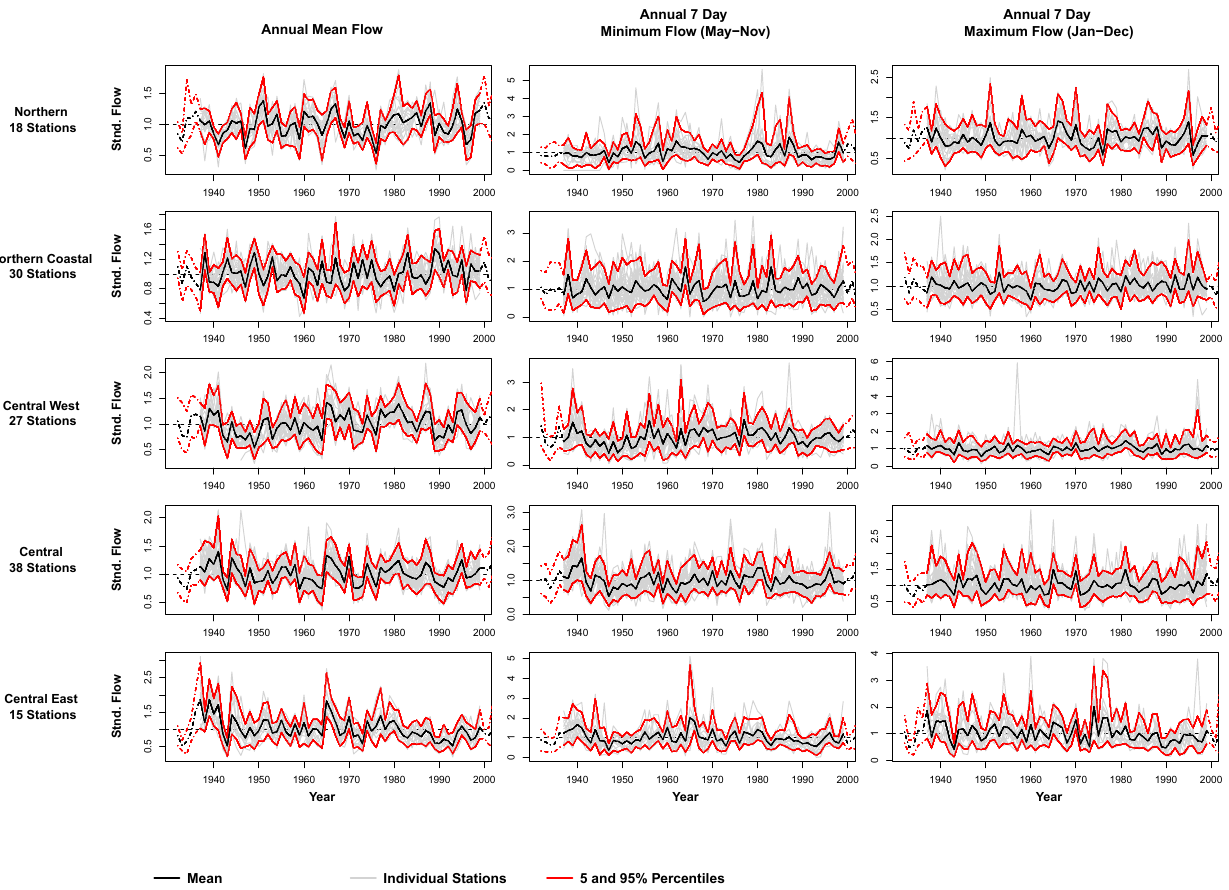
Fig. 4. Variability in RA STD time series (black) and individual STD time series (grey). Red lines show the 5th and 95th percentiles of the combined STD